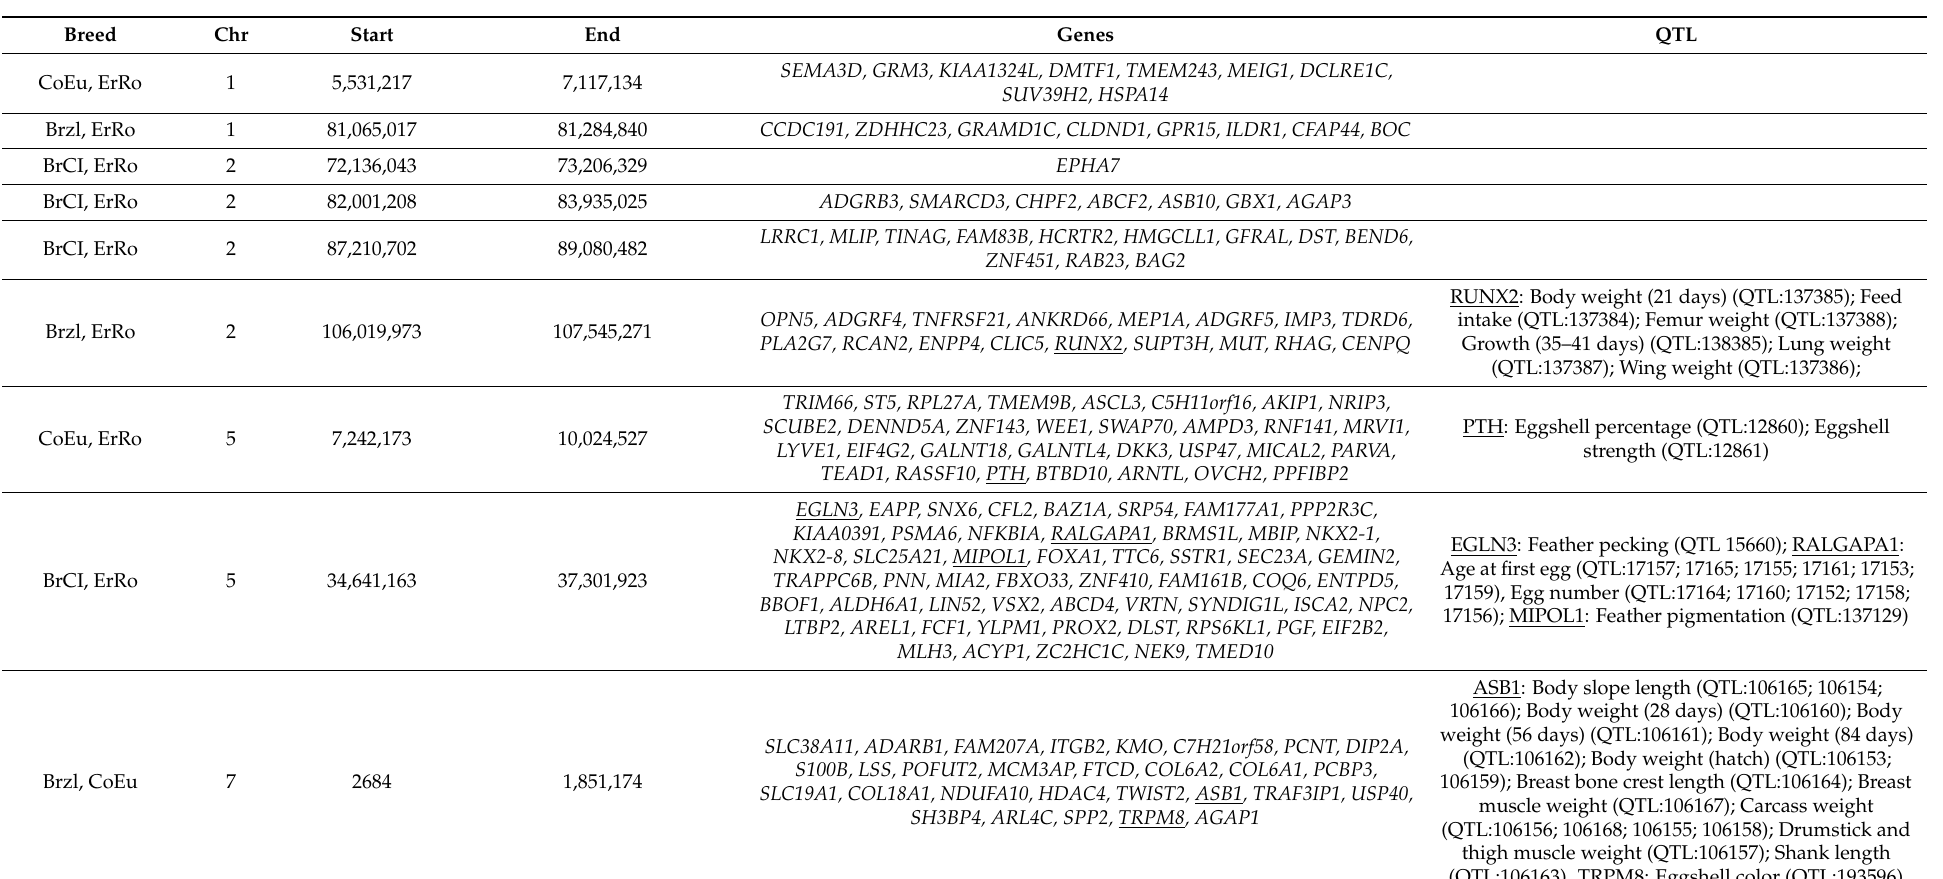
Table 3. ROH_islands found in common among breeds together with the annotated genes (NCBI Annotation Release: 103—Turkey), and the overlapping QTLs (reference QTL_IDs refer to chicken studies—Chicken QTLdb). ROH lengths are expressed in base pairs